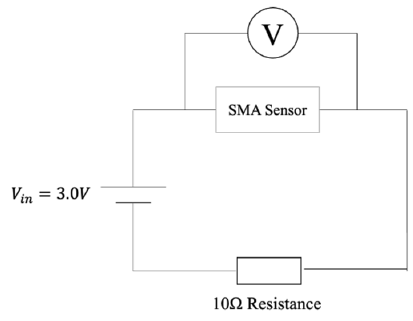
Figure 8. SMA driving circuit.